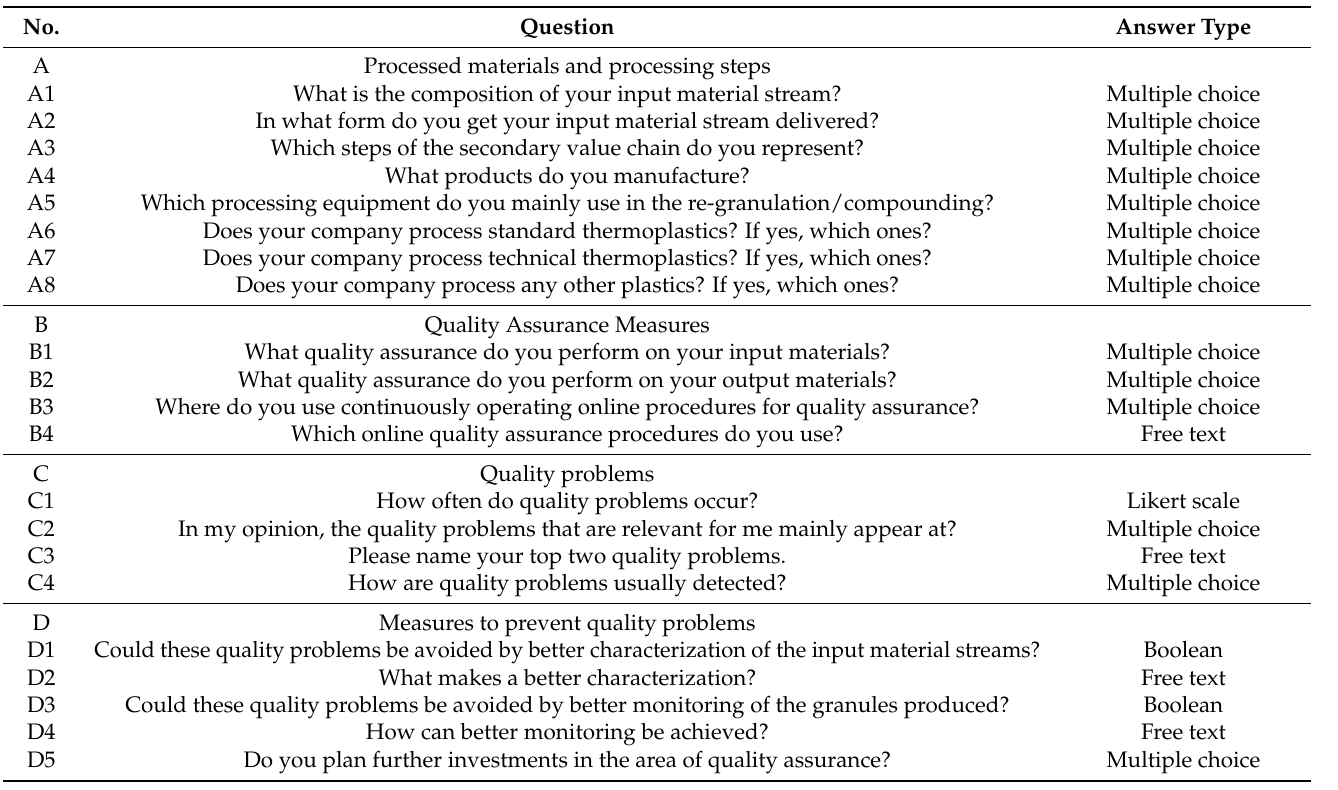
Table 2. Overview of questions from the survey.